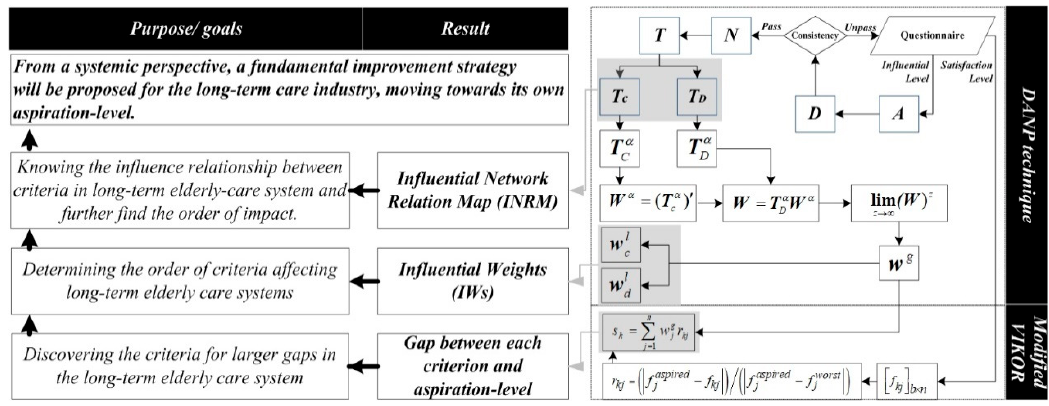
Figure 2. Operation and purpose of the proposed method.